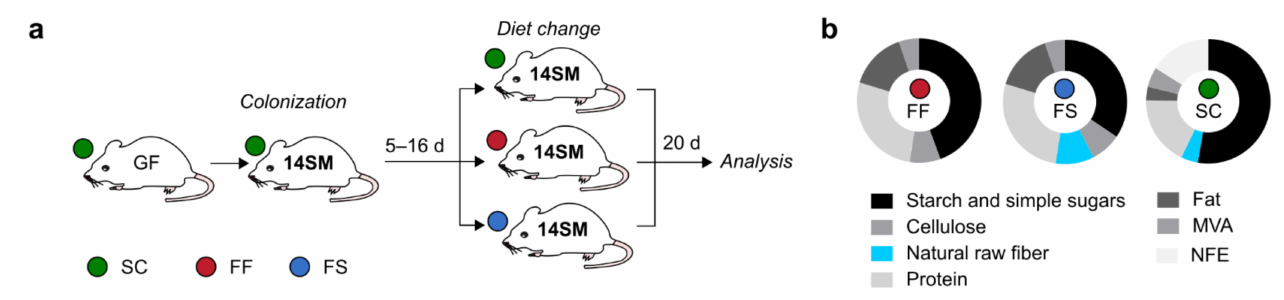
Figure 1. Experimental outline to study effects of concentrated raw fibers on a 14-member microbial community. ( a ) Experi- mental outline. Germ-free (GF) C57BL/6N ( n = 15), raised and maintained on a standard mouse chow (SC) were colonized with the 14SM community. Five to sixteen days after colonization, mice were either continued to be fed a SC diet ( n = 7) or switched to a fiber-free (FF; n = 4) or a fiber-supplemented (FS, n = 4) diet. Twenty days after diet switch, cecal and fecal samples were harvested for analyses. ( b ) Composition in % ( w / w ) of the diets; MVA = Minerals, vitamins, and ash; NFE = Nitrogen-free extracts.